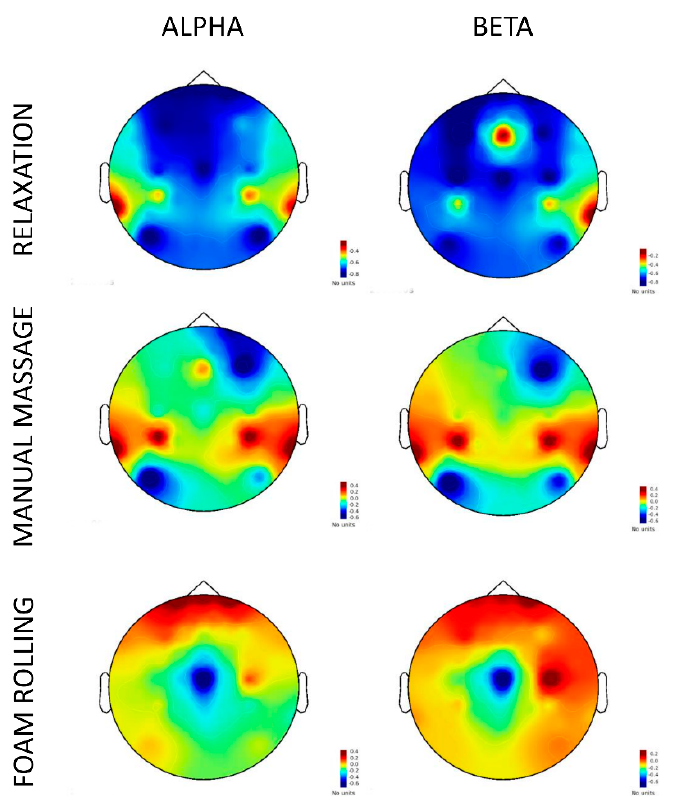
Figure 4. Spatial distribution within the sensors–space of the pretest vs. posttest normalized differ- ence in EEGrs power across alpha (8–12 Hz) and beta (13–30 Hz) frequency ranges ((A − B)/(A + B)). Noteworthy, neural synchronization was primarily detected from parietal sensors for MM and frontal sensors for